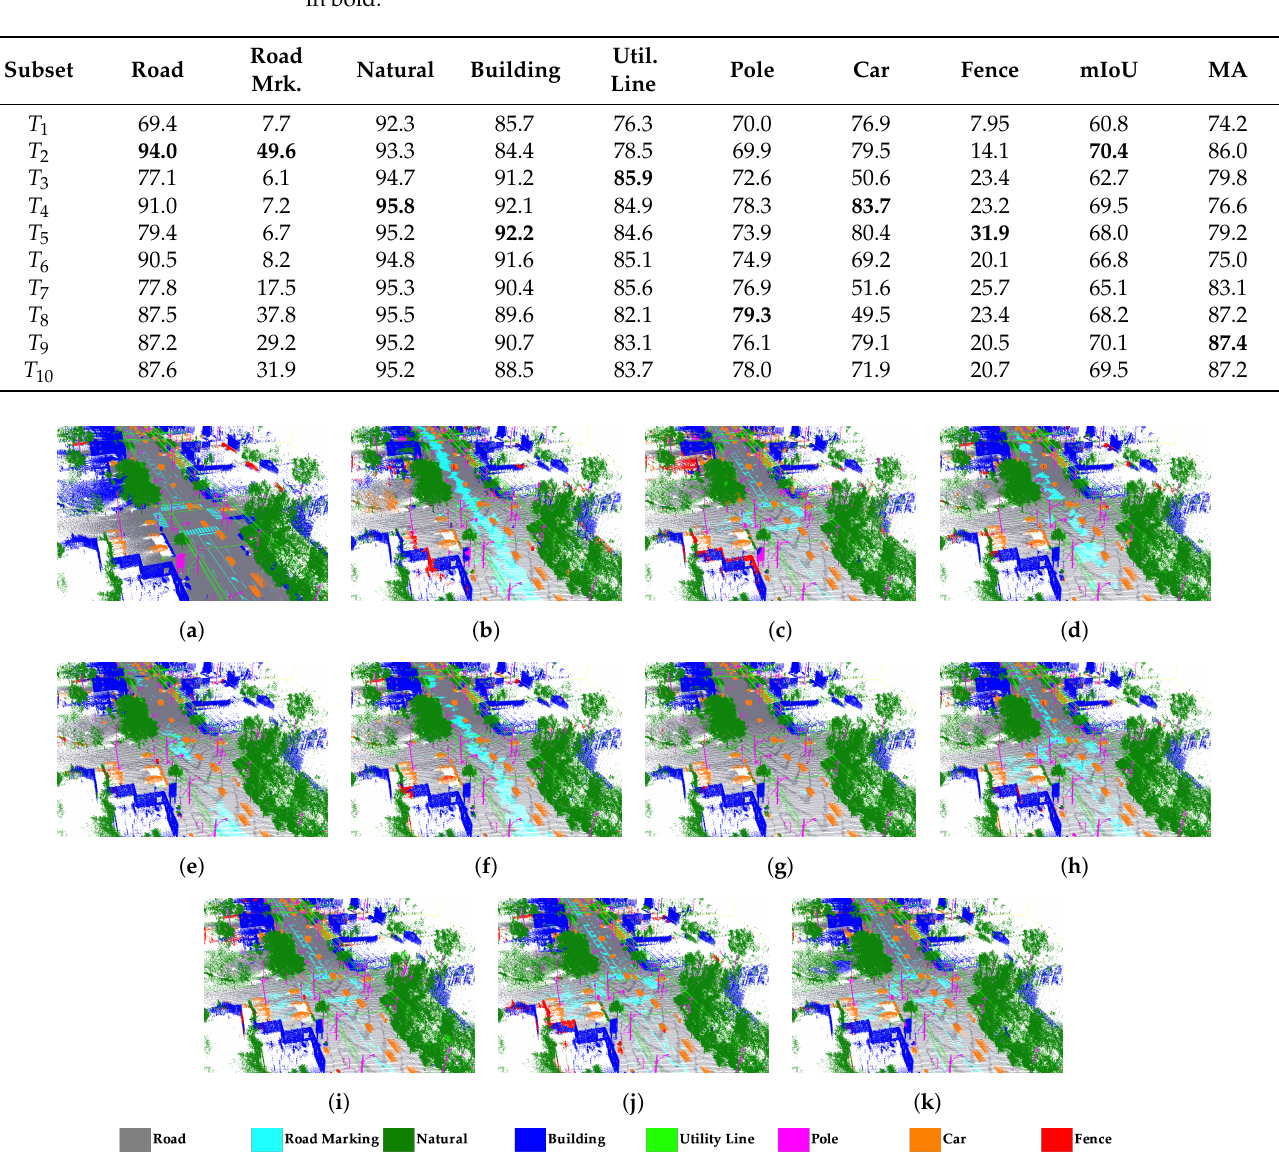
Table 1. Class-based results of RandLA-Net on subsets of Toronto3D. Highest values are marked in bold.